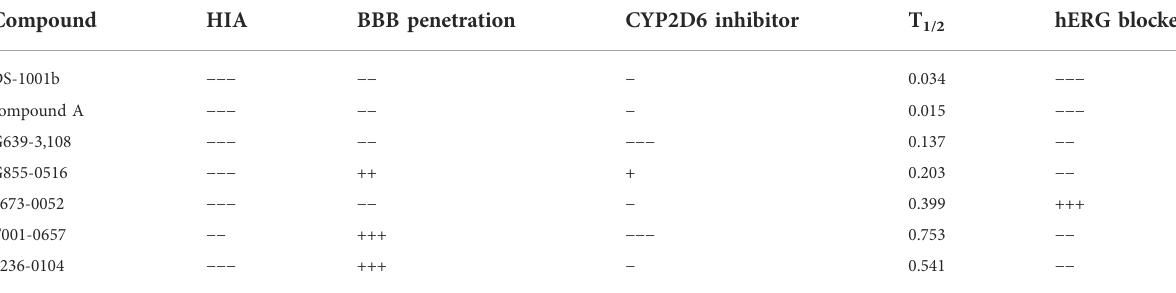
TABLE 2 The ADMET values of the screened compounds.